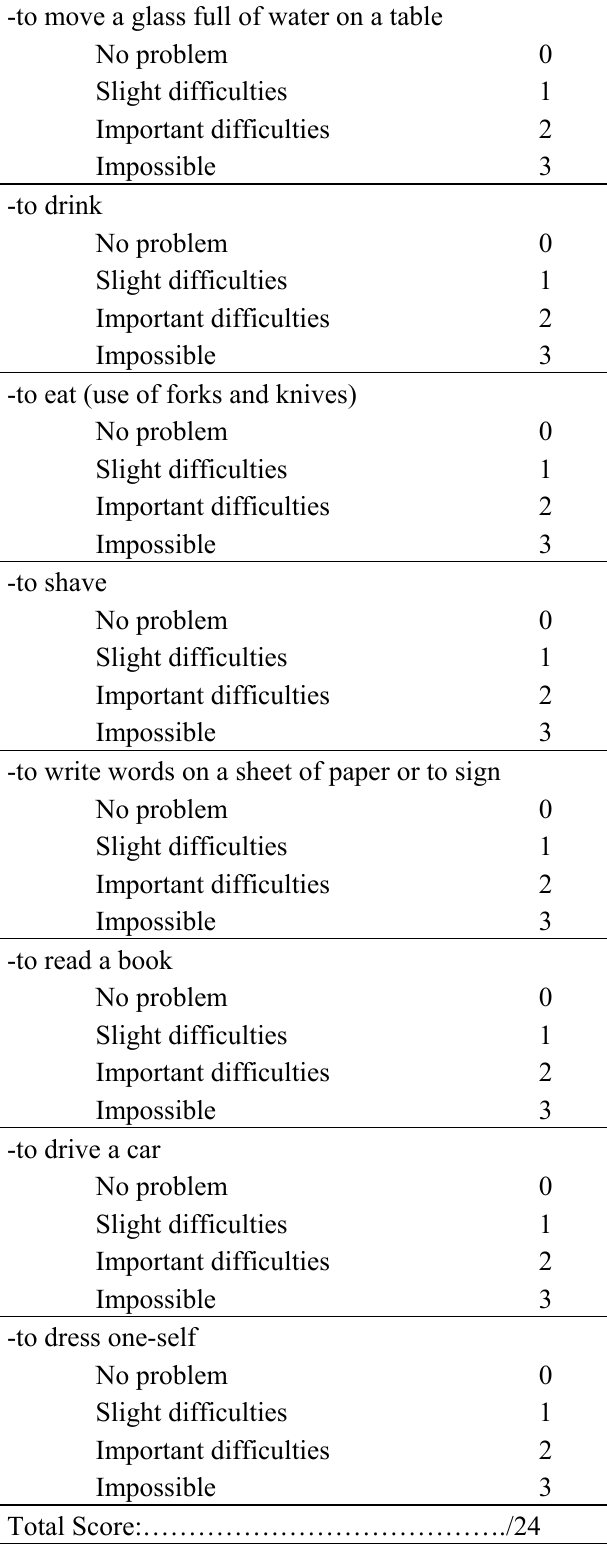
Table 1 . Questionnaire of tremor-induced difficulties encountered during daily life (ADL-T24 score). -to move a glass full of water on a